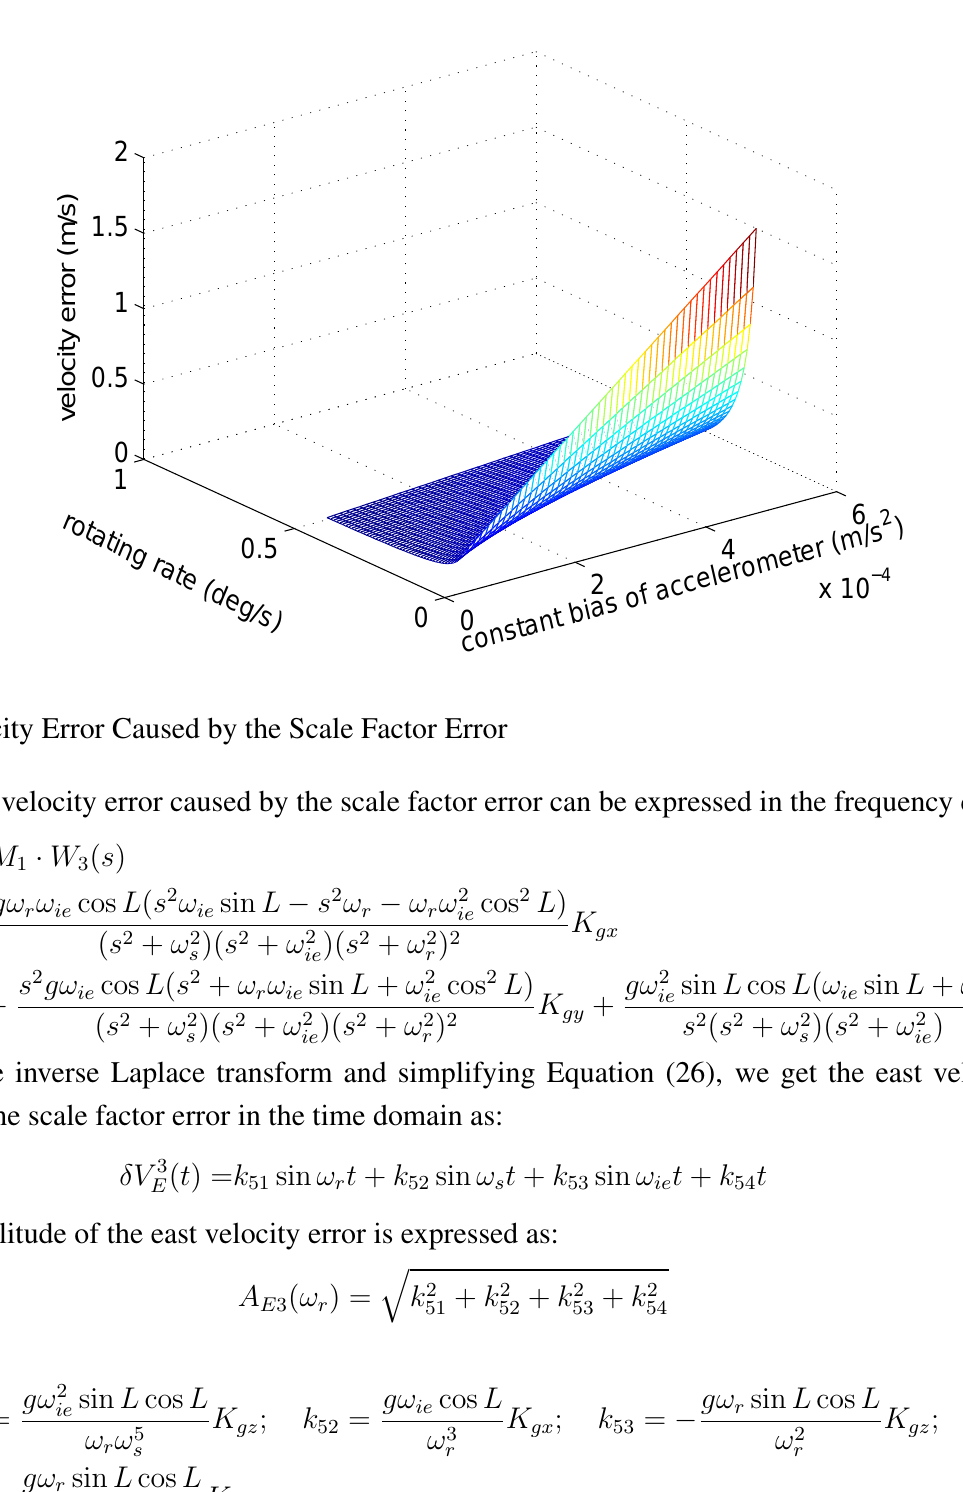
Figure 4. The relationship curve of the amplitude of the velocity error, the constant bias of the accelerometer and the rotating angular